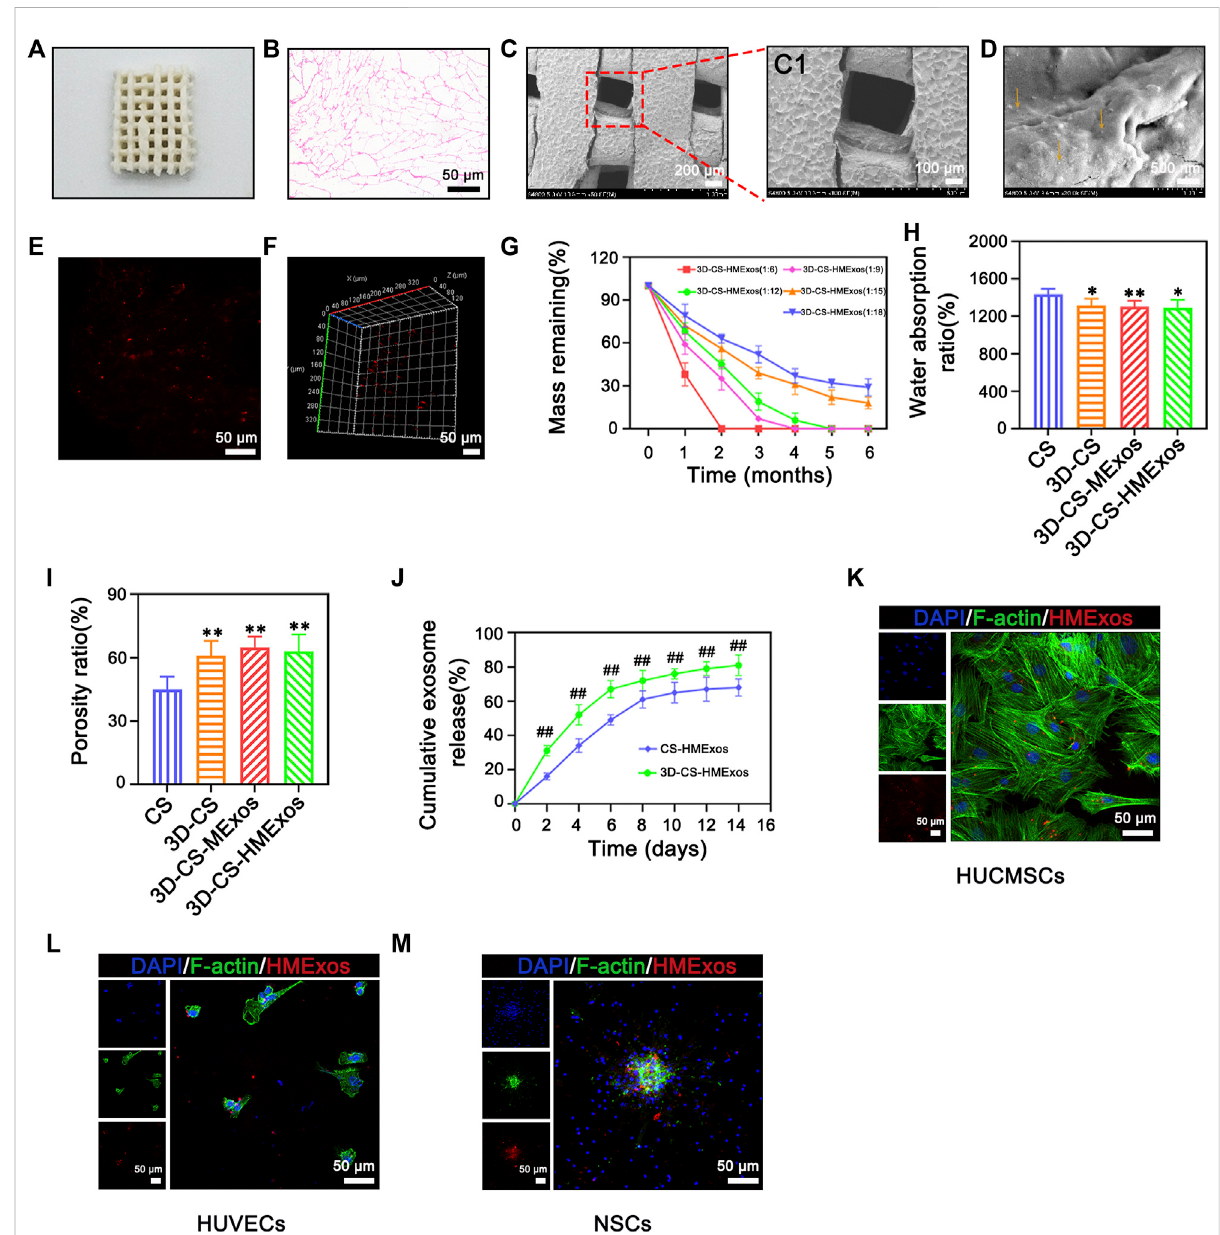
FIGURE 2 Characteristics of 3D-CS-HMExos. (A) General structure of 3D-CS-HMExos. (B) HE staining revealed the internal structure of 3D-CS-HMExos. (C) SEM micrographs of 3D-CS-HMExos. C1 is an enlarged view in the dashed box. (D) SEM image of 3D-CS-HMExos. The yellow arrow showed exosomes loaded on 3D-CS-HMExos. (E) Image of exosomes labelled with PKH26 in 3D-CS-HMExos. (F) 3D immuno fl uorescence staining images revealed the distribution of Exos in 3D-CS-HMExos (G) Degradation rate of 3D-CS-HMExos with different ratios of collagen and silk fi broin within 6 months. (H) Water absorption ofscaffolds. (I) Porosity ratioanalysisof thefour groups. High porosity can increase thescaffoldsurfacearea/ volume ratio, which is bene fi cial for exosome adhesion. (J) Cumulative release pro fi le of exosomes from 3D-CS-HMExos and CS-HMExos. (K – M) Representative immuno fl uorescence staining images showed that the exosomes released from the scaffold could be phagocytized by HUCMSCs (K) , HUVECs (L) and NSCs (M) in vitro . Nuclei were stained with DAPI (blue), exosomes were stained with PKH26 (red), and the cytoskeleton was stained with F-actin (green). * p < 0.05, ** p < 0.01 vs. CS. # p < 0.05, ## p < 0.01 vs.